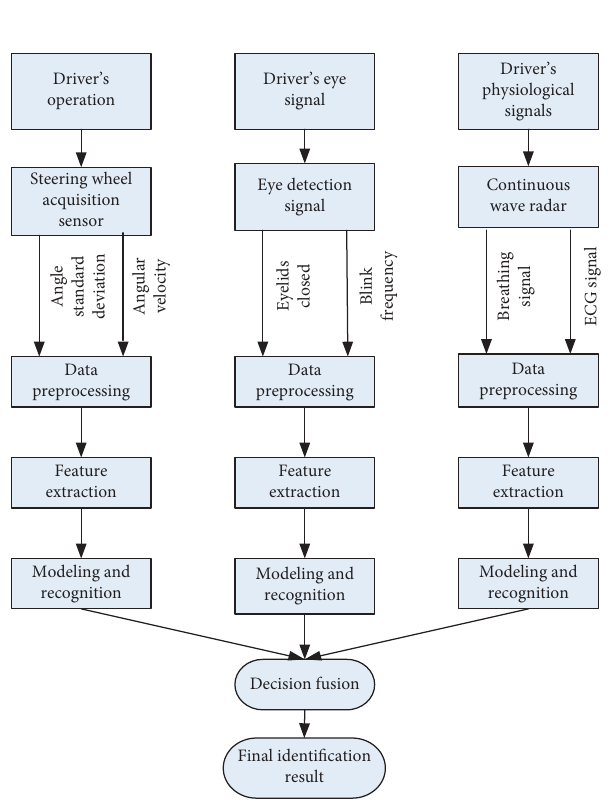
Figure 11: Decision-making layer fusion steps.